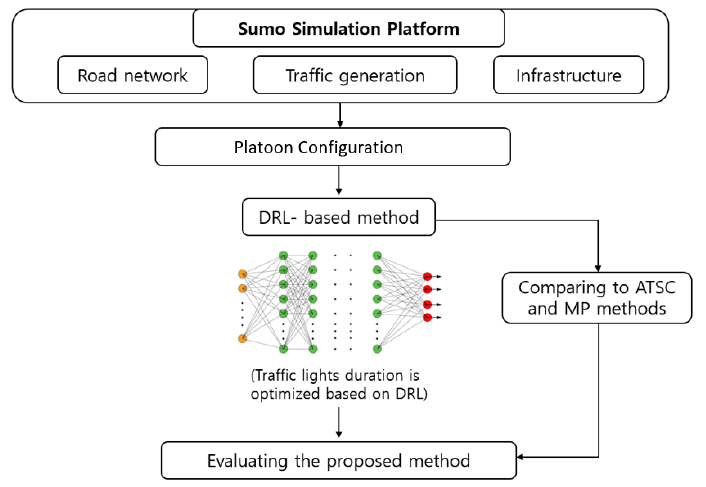
Figure 1. Research